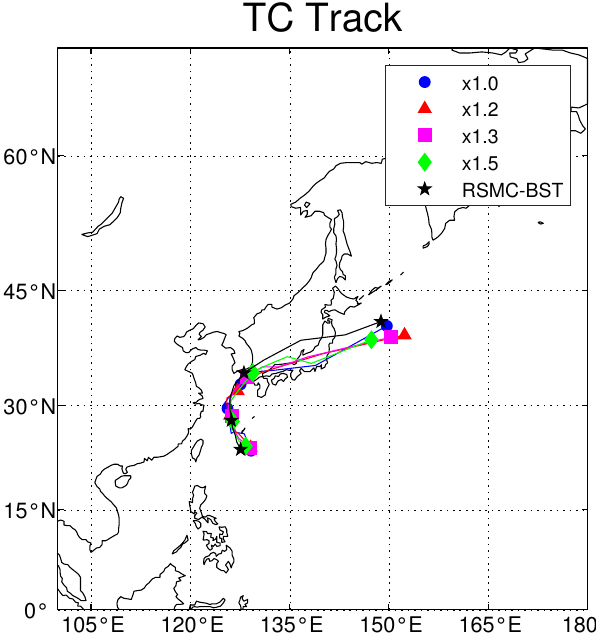
Figure 8. The tracks of Typhoon Chaba in observation (best-track, black line) and each simulation. The tracks are plotted for 3–6 October